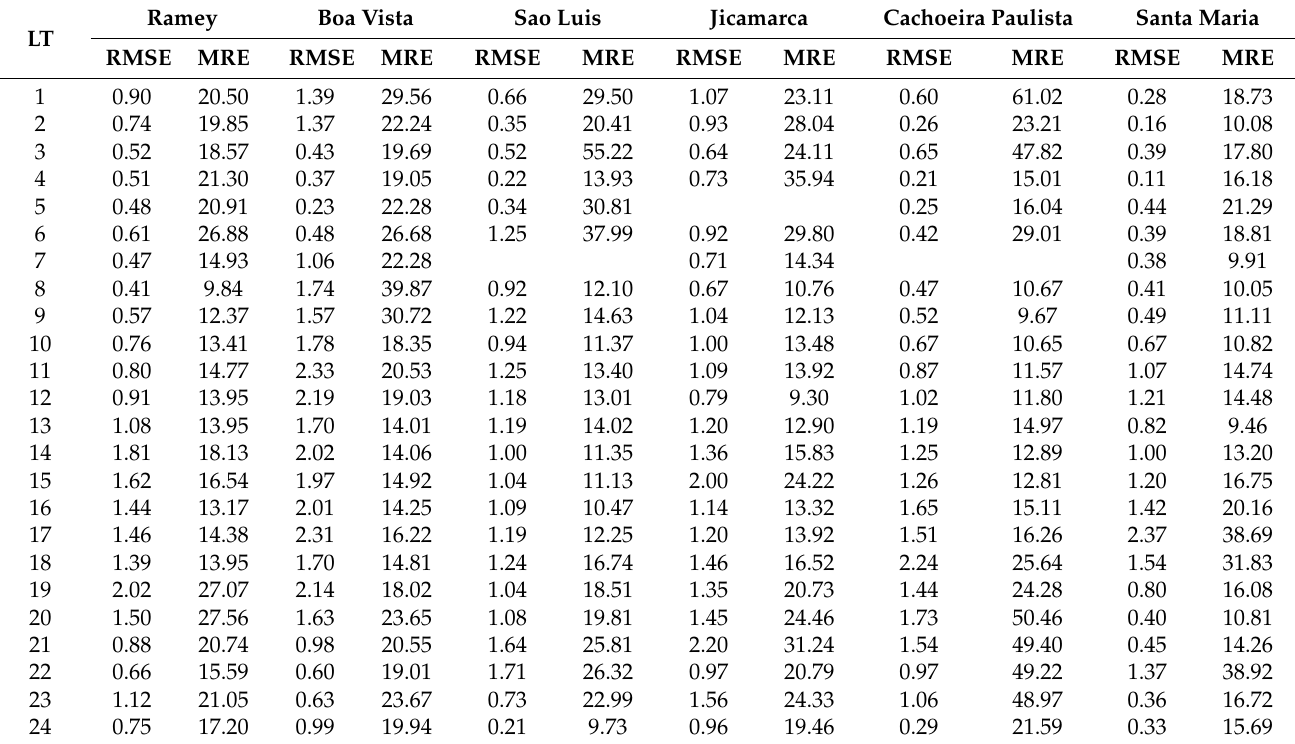
Table A1. Statistics of the differences in N m F 2 obtained from the COSMIC-2 and ionosonde (as the reference) at the six ionosondes under quiet geomagnetic conditions in terms of hourly RMSE (10 5 el/cm 3 ) and hourly mean |Rel E | (MRE, %).